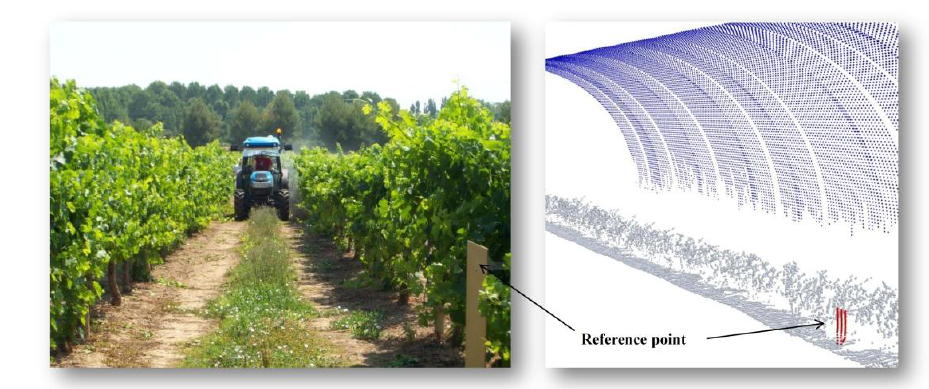
Figure 4. Measuring procedure: a LiDAR sensor placed on the mast reads the canopy on the left side of the tractor